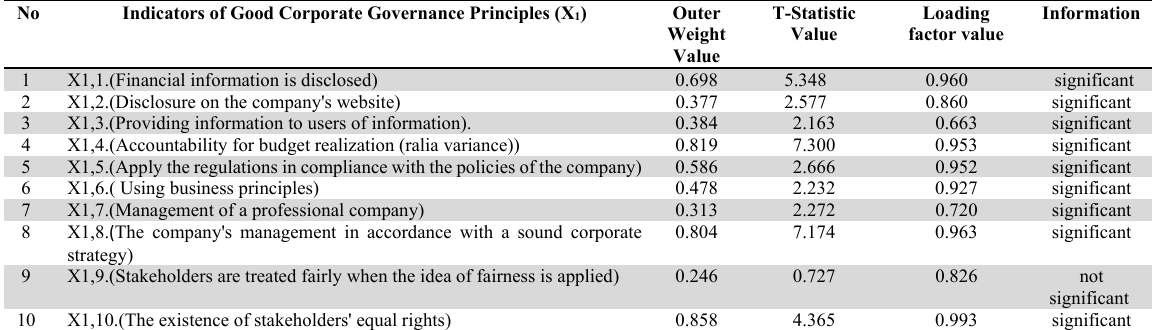
Variables with Formative Indicators: Validity and Reliability Test Results